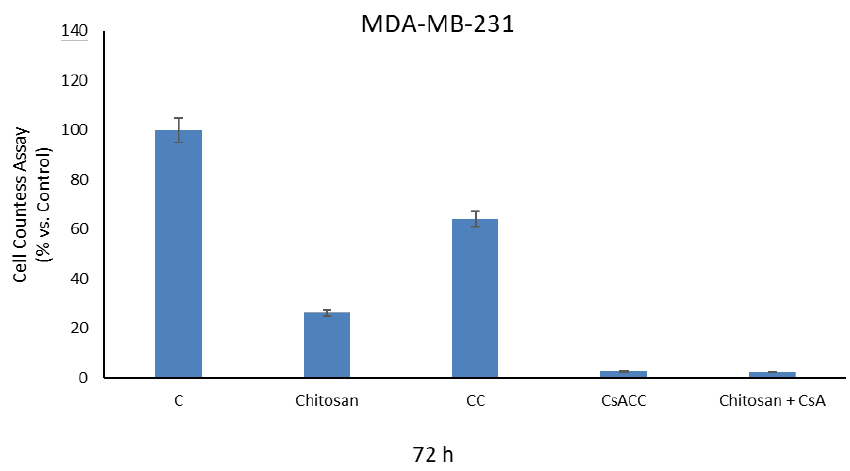
Figure 7. Confocal imagine of chitosan membrane (CTR), membrane based on free CsA containing coumarin-6 ( a ), and membrane based on CsACC containing cumarin-6 ( b ).